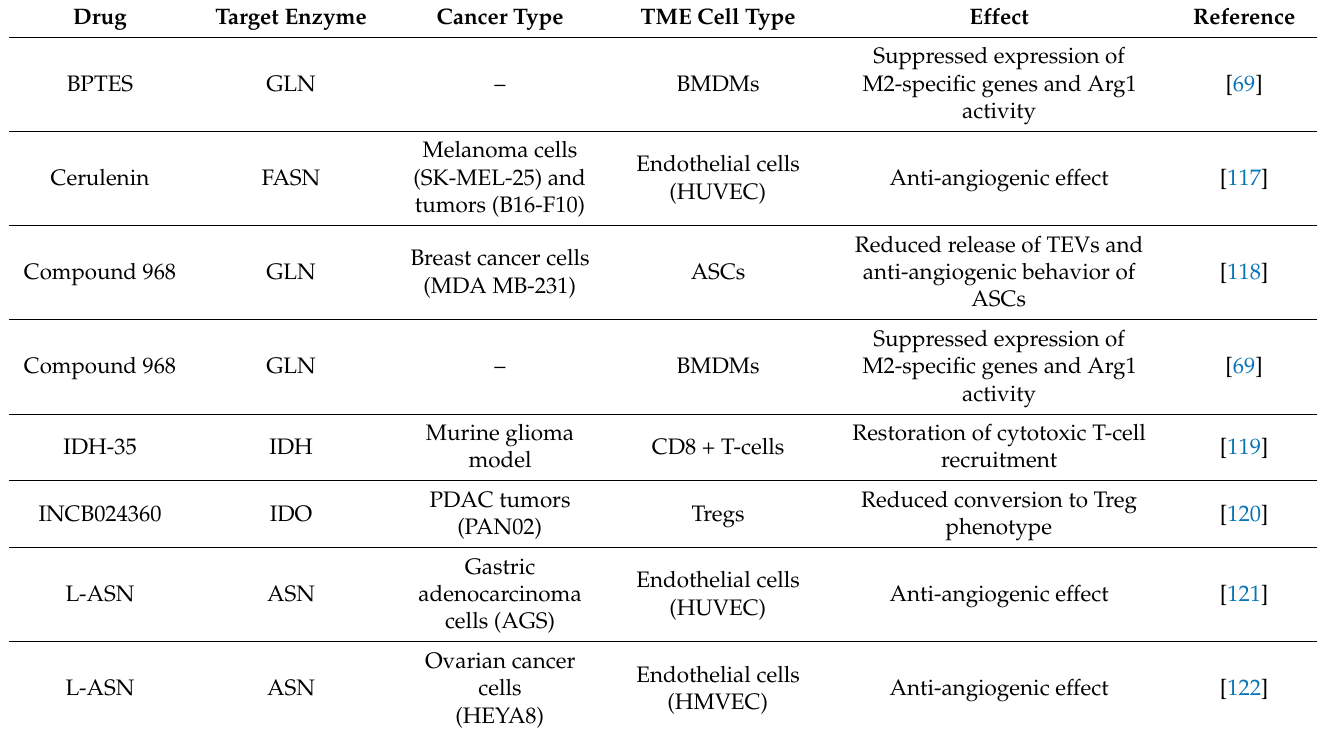
Table 1. A list of TME-related effects caused by therapies targeting cancer cell metabolic reprogramming.